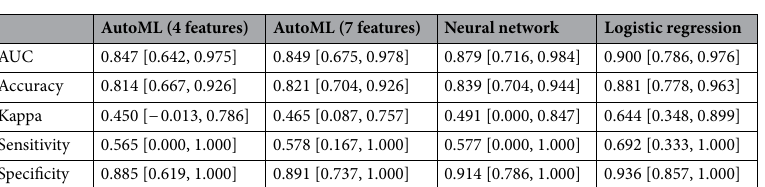
Table 3. Classification results for AutoML (using 4 and 7 features), neural network (using 6 features) and logistic regression (using 3 features). All values calculated as means of 100 repetitions (100 cycles) using independent test data. Values in brackets: 95% confidence